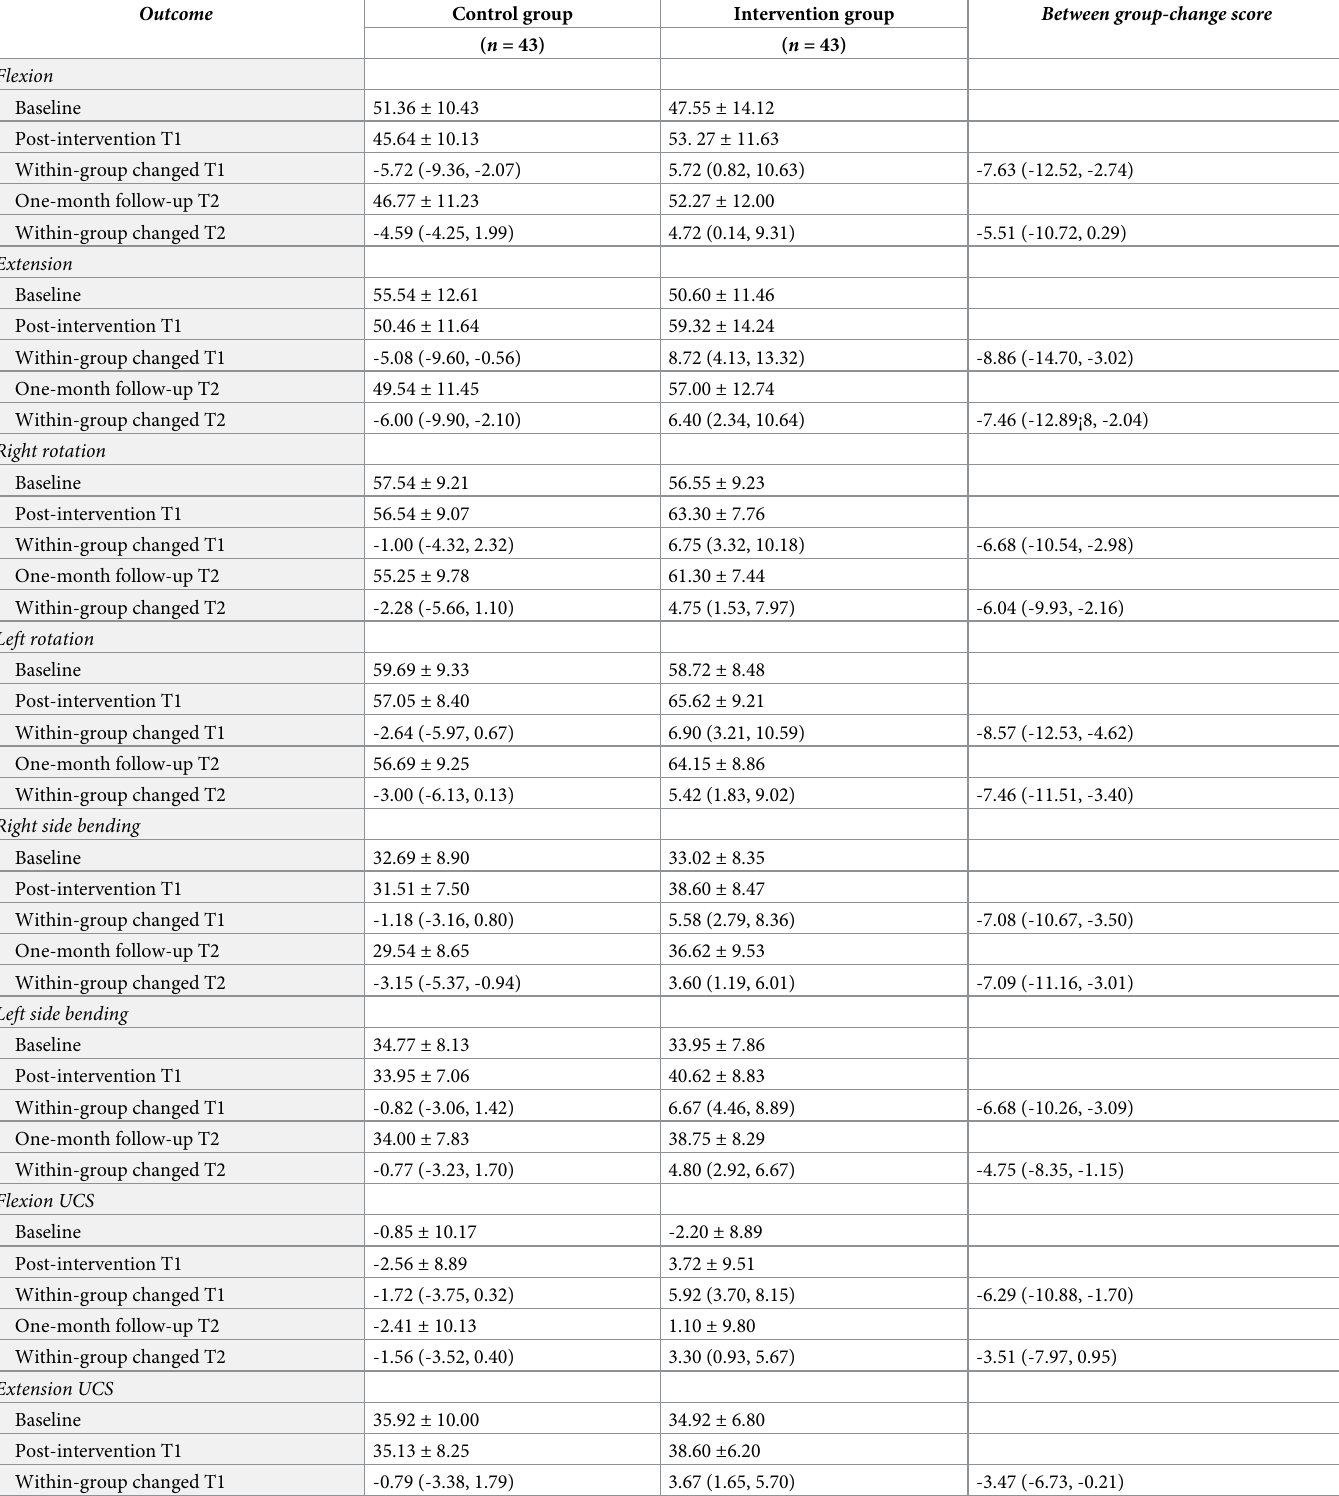
Table 3. Outcome data range of